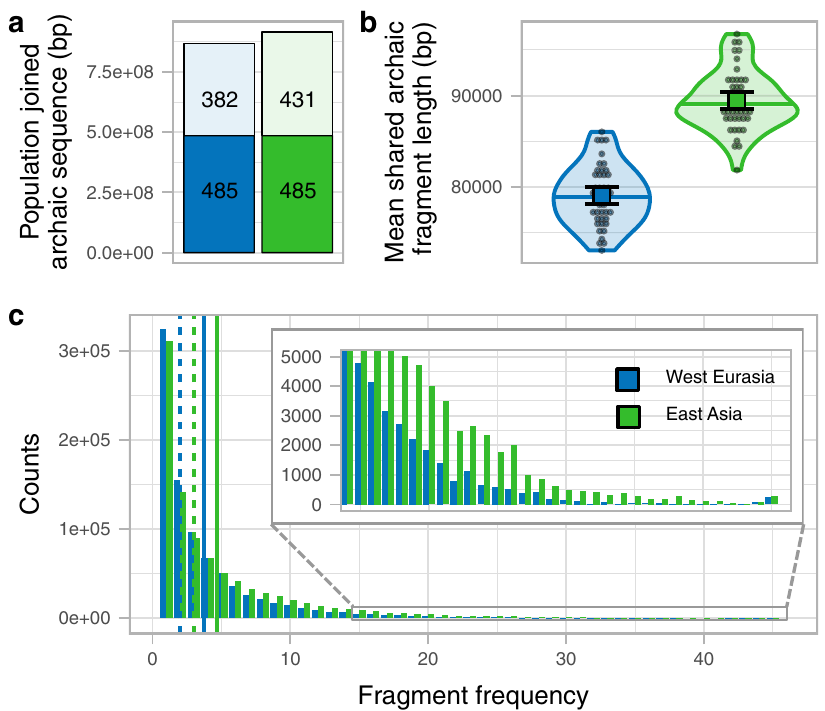
Fig. 2 West Eurasia and East Asia archaic fragments comparison. a Joined archaic sequence in both geographic regions (colour coded). The portion of the bar painted in plain colour shows the shared amount between the regions. The rest of the column shows the sequence private of each region. The numbers in each section denote the corresponding archaic sequence in Mb. The sample sizes of individuals for each region for which summary statistics are derived from, together with other statistics, are indicated in Supplementary Table 6. b The mean archaic fragment length distributions of individual shared fragments among regions per region (colour coded) as violin plot. Individual values are shown as dots. The median is shown as a horizontal line in each violin plot. The mean and its 95%CI of each distribution are shown as a coloured square with their corresponding error bars. The sample sizes of individuals for each region for which summary statistics are derived from, together with other statistics, are indicated in Supplementary Table 7. c The number of 1 kb genomic windows ( y -axis) in which an archaic fragment has been found in a certain number of individuals ( x -axis) for each region. The insert shows the high-frequency bins. Vertical lines show the mean (plain lines) and median (dashed lines) for each region. The sample sizes of individuals for each region for which summary statistics are derived from, together with other statistics, are indicated in Supplementary Table